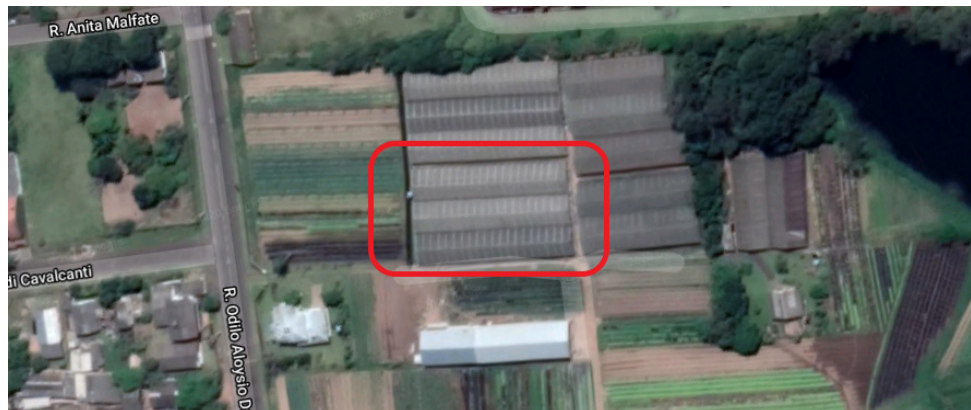
Figure 4. Aerial image of the greenhouses that used the prototype.